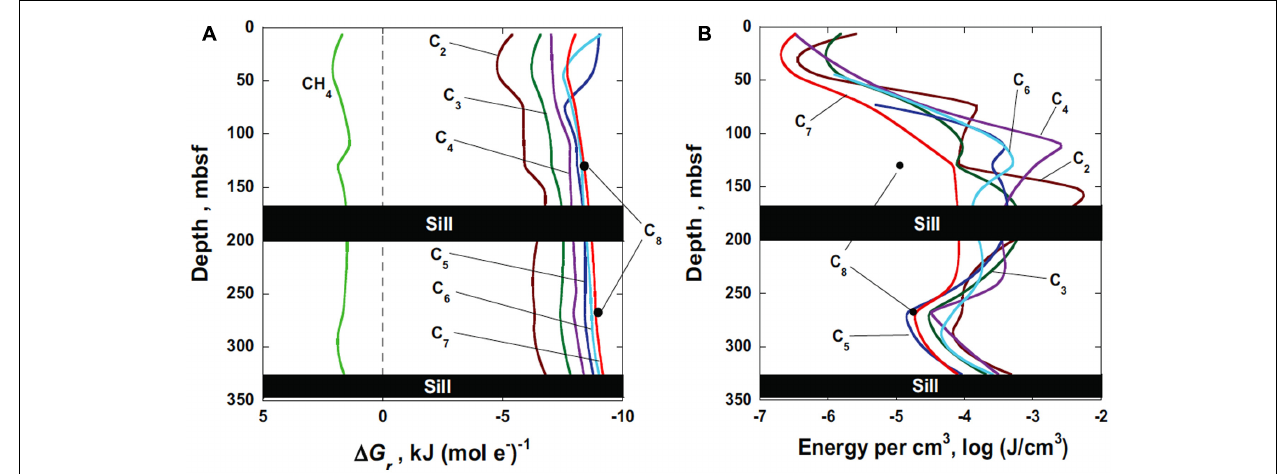
FIGURE 3 | (A) Gibbs energy of sulfate reduction, (cid:2) G r , coupled to methane and C 2 –C 8 n -alkane oxidation in Guaymas Basin sediments (DSDP Leg 64, Hole 481A) in units of Joules per mole of electrons transferred, J (mol e − ) − 1 . The reactions that these values of (cid:2) G r refer to are listed in Table 1 .